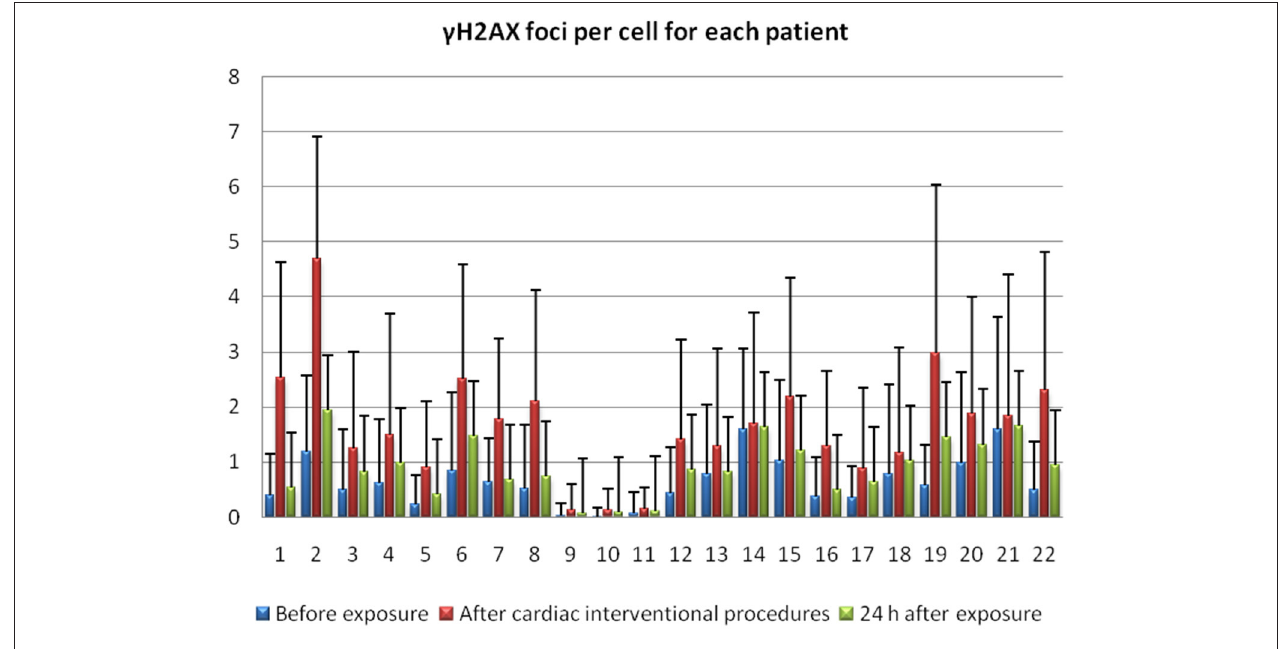
FIGURE 2 | γ -H2AX foci for 22 individuals before the exposure, immediately after interventional cardiology procedure and 24h following